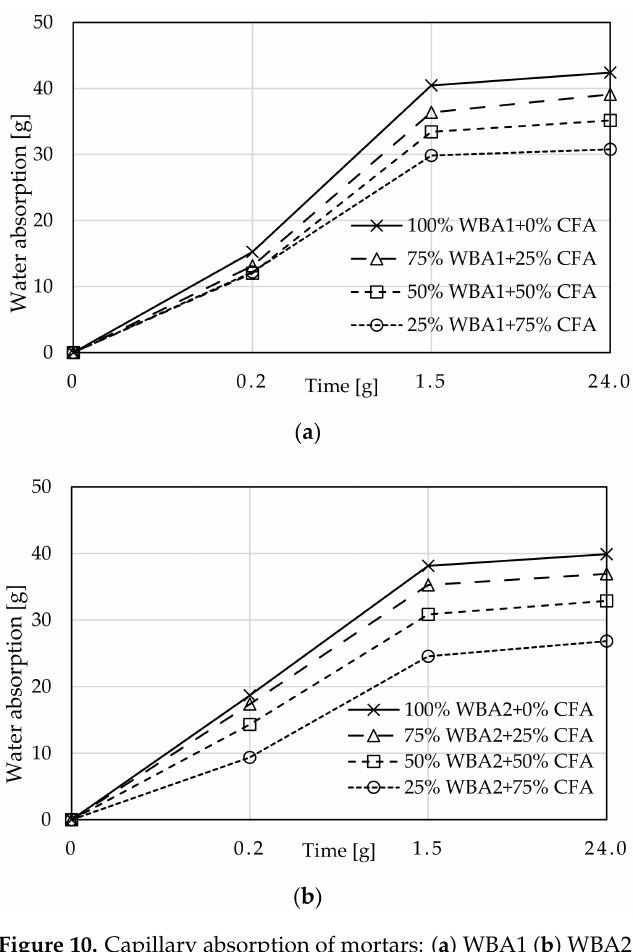
Figure 10. Capillary absorption of mortars: ( a ) WBA1 ( b ) WBA2.